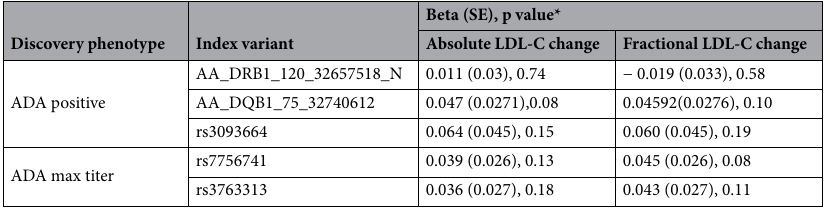
Table 4. Genetic association with LDL-C response at primary index variants. *From linear regression including covariates age, sex, smoking, study, and eigenvectors of population substructure. Units of SD after rank normal transformation of